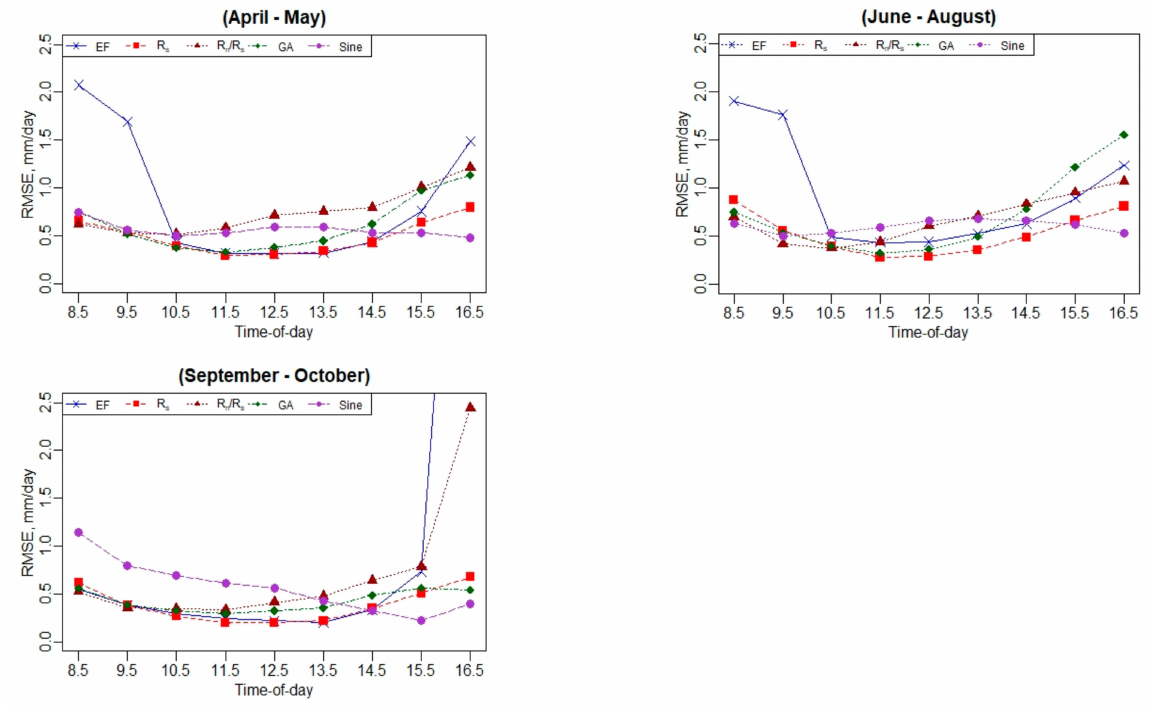
Figure A4. Daily RMSE performance using hourly EC ET